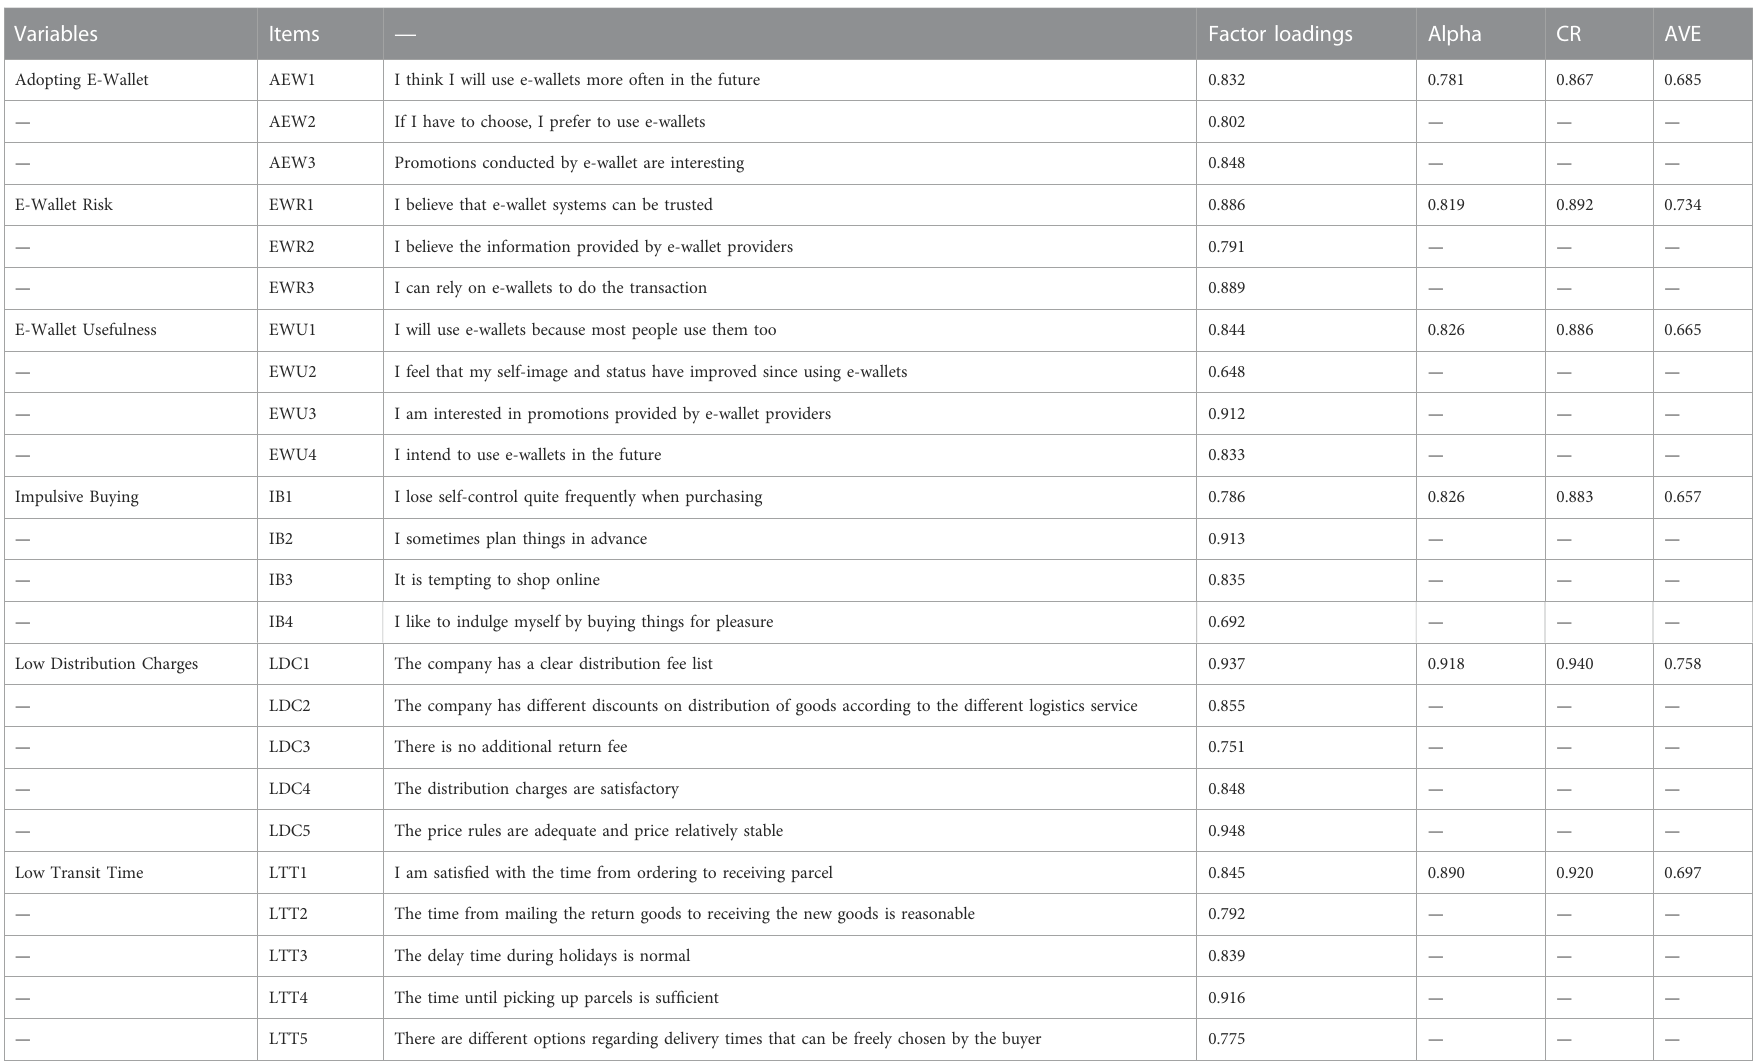
TABLE 1 Factor loadings, alpha, CR, and